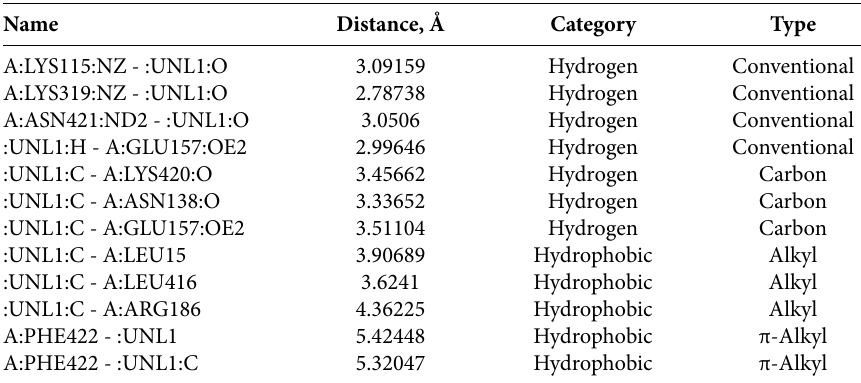
Table 4. The list of in silico calculated bonds formed between tacrolimus and UDP-N-acetylmu- ramoyl-L-alanine: D-glutamate ligase (MurD) active site